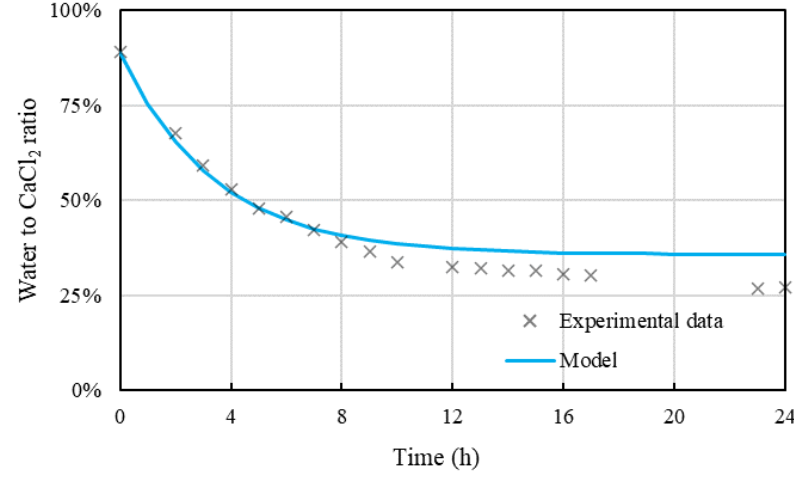
Figure 13. Exponential decay/growth model for CaCl 2 moisture desorption.